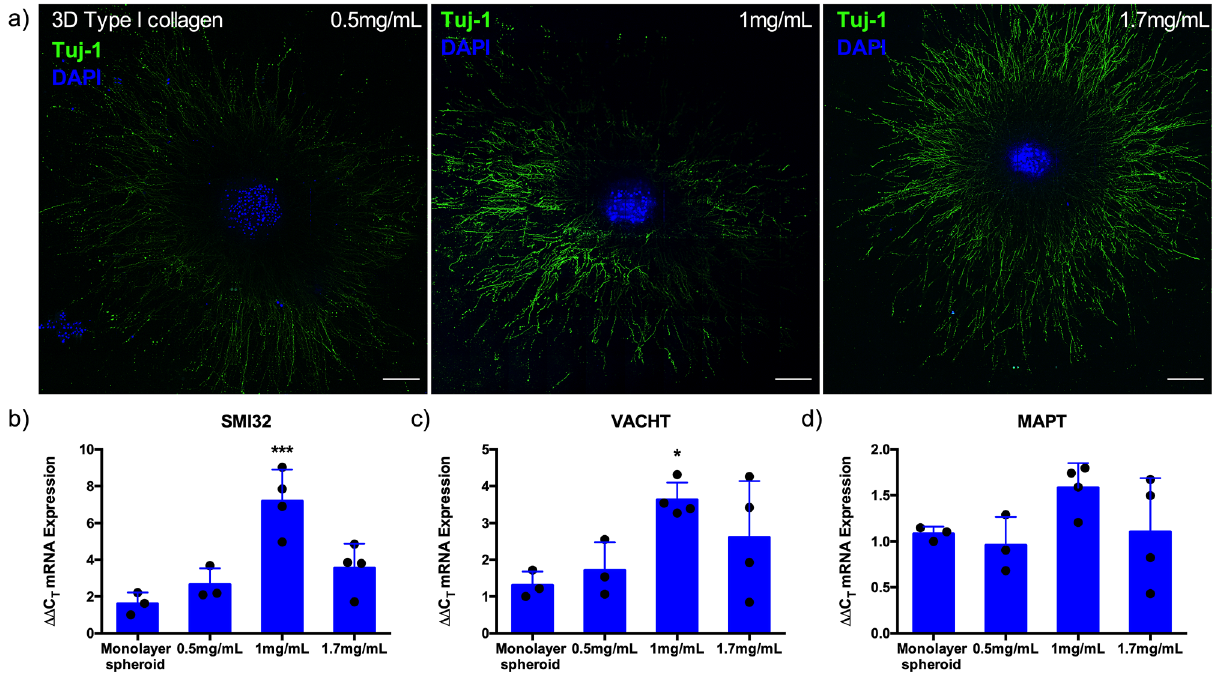
Figure 3. Culture of iPSC motor neuron spheroids within 3D collagen I matrices enhances mRNA expression of heavy neurofilament (SMI-32), vesicular transporter of acetylcholine (VAChT) and axonal extension (MAPT). ( a ) Confocal tile scans of motor neuron progenitor spheroids suspended within 3D collagen I matrices of different concentrations (0.5, 1 and 1.7 mg/mL) adhere and extend axons over 5 days. ( b ) mRNA expression of mature motor neuron markers SMI32 and ( c ) VACHT, and ( d ) MAPT as indication of amount of axonal extension compared to adhered monolayer spheroids. Data presented ± standard deviation (SD). *P ≤ 0.05 and ***P ≤ 0.001. Scale bars = 200